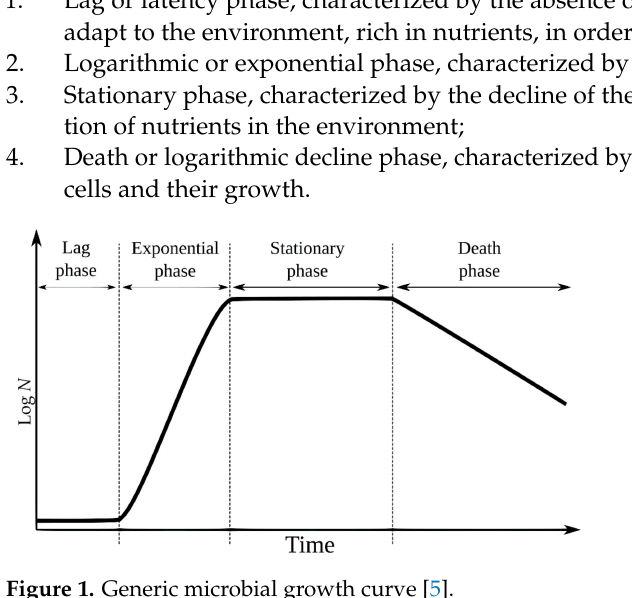
Figure 1. Generic microbial growth curve